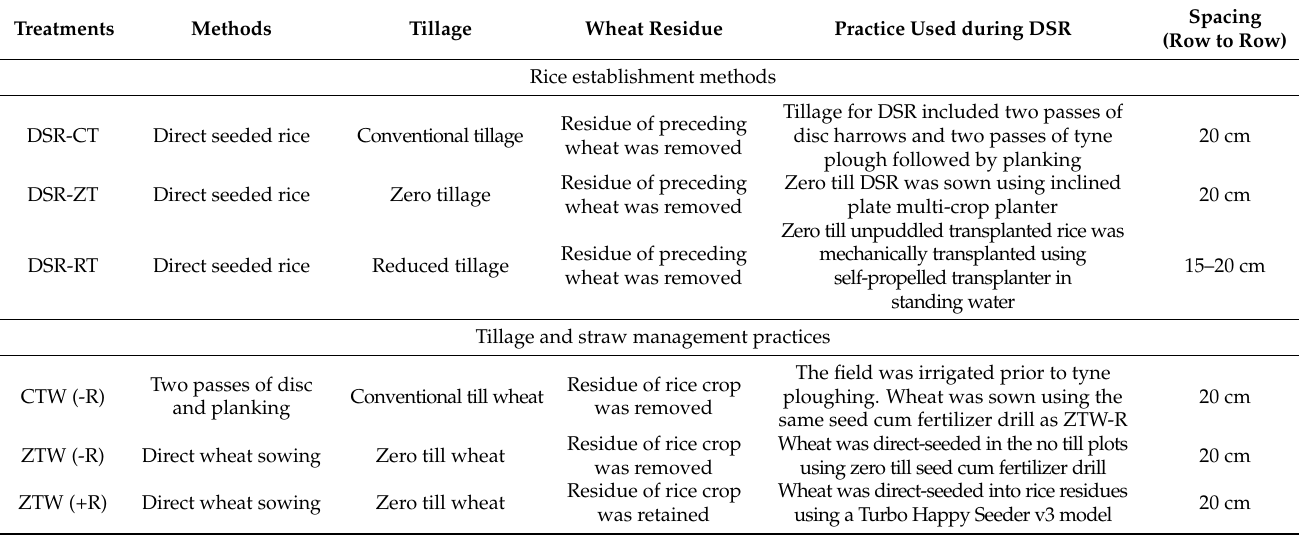
Table 1. Description of treatments in the experimental field under rice establishment methods in the rice–wheat cropping system.